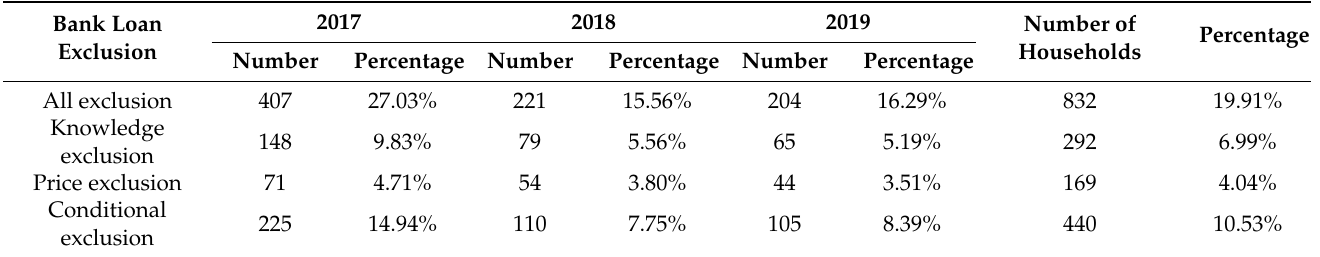
Table 4. The current situation of rural households facing bank loan